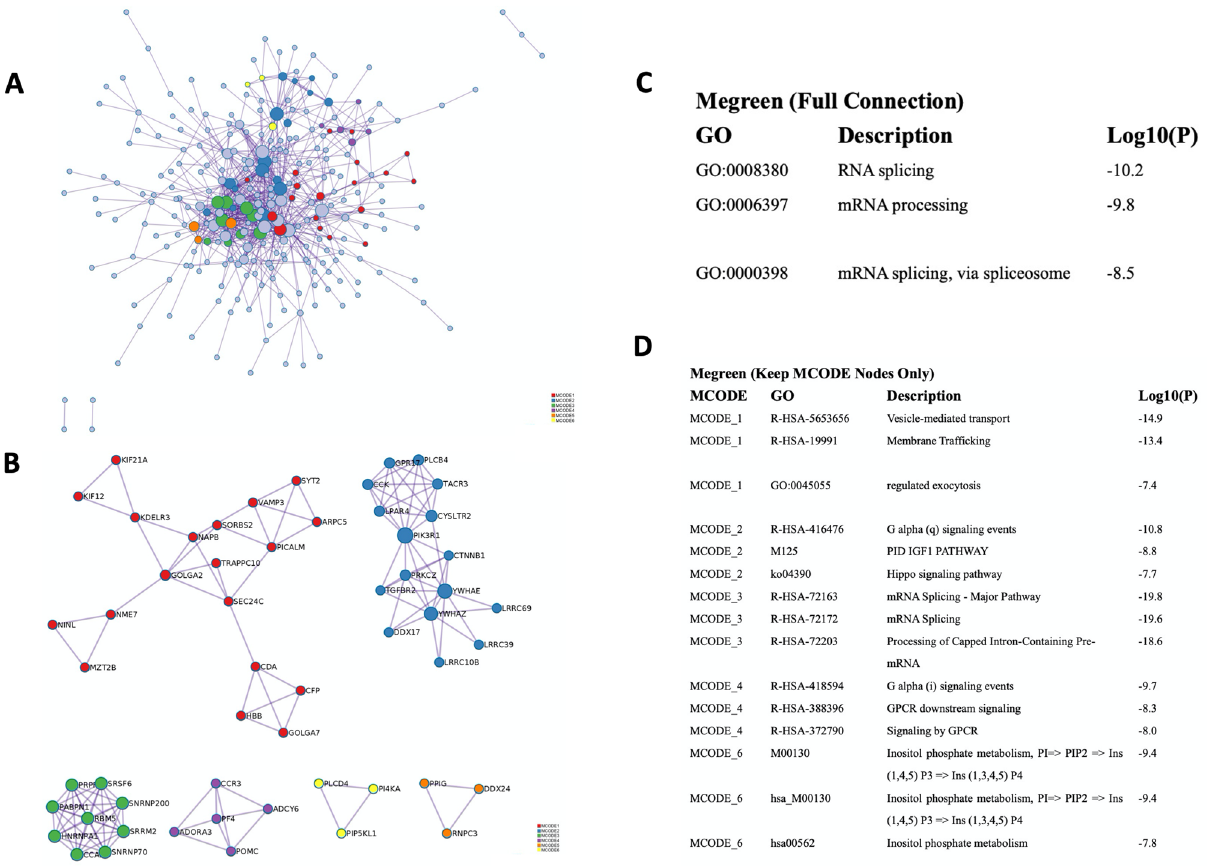
Figure 8. Pathway enrichment analysis of the green module (Metascape (http:// metas cape. org/)). ( A ) Protein– protein interaction (PPI) network of the green module. ( B ) GO enrichment analysis for PPI network and its MCODE network components. ( C ) Top three best p-value terms retained from GO enrichment analysis for original PPI network and its MCODE network. ( D ) Top biological terms etained from GO enrichment analysis for only MCODE nodes